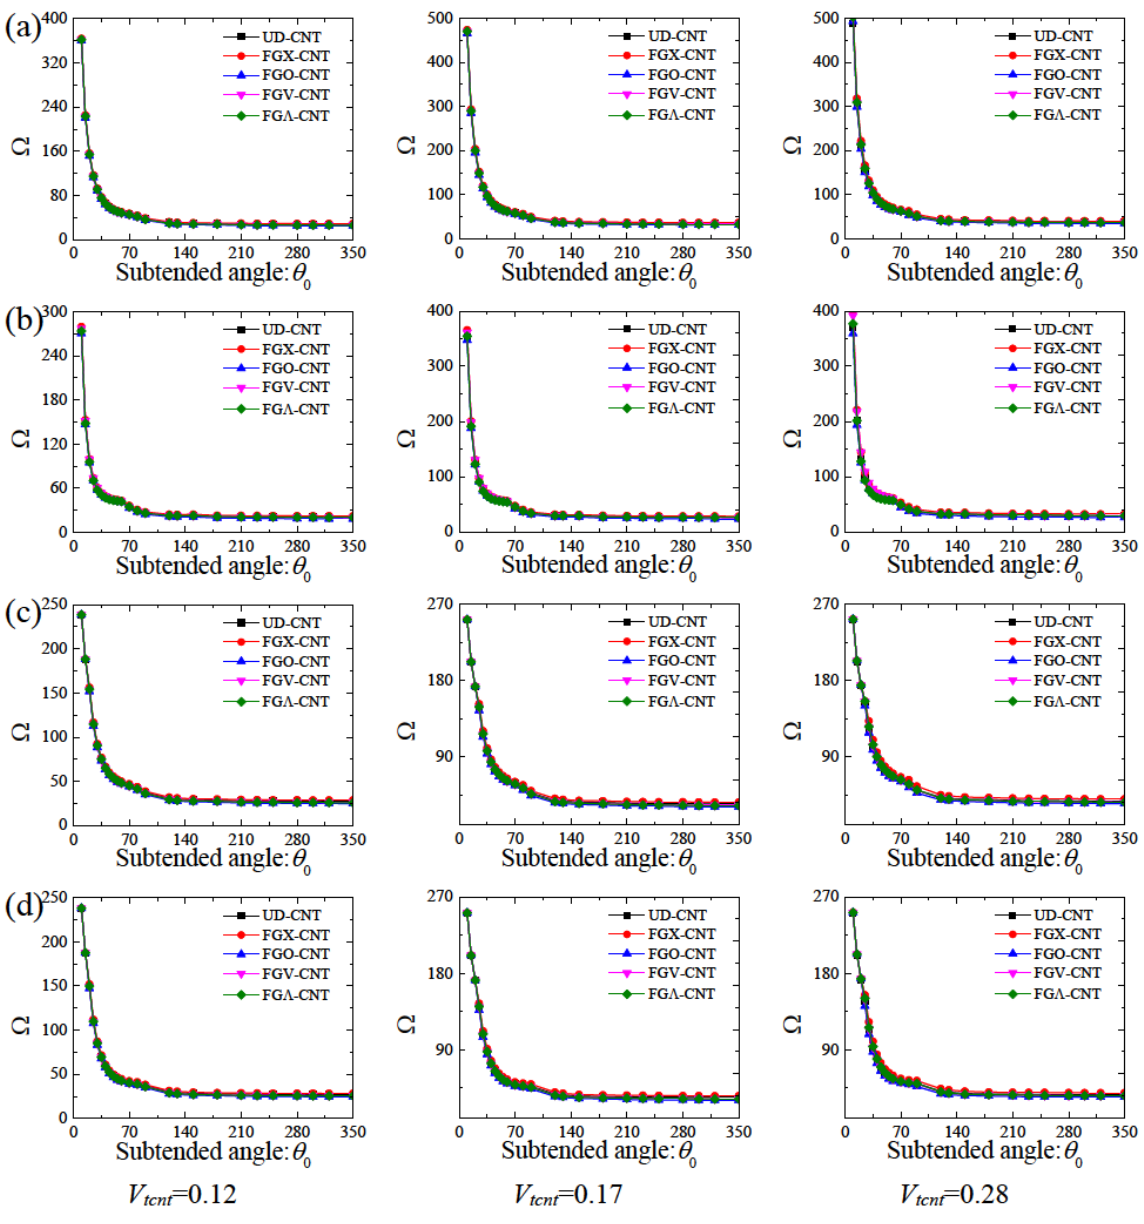
Figure 10: Variation of the fundamental frequency parameters Ω versus the subtended angle for FG-CNT reinforced composite panel with various boundary conditions: (a) CCCC; (b) SSSS; (c) E 1 E 1 E 1 E 1 ; (d) E 3 E 3 E 3 E 3